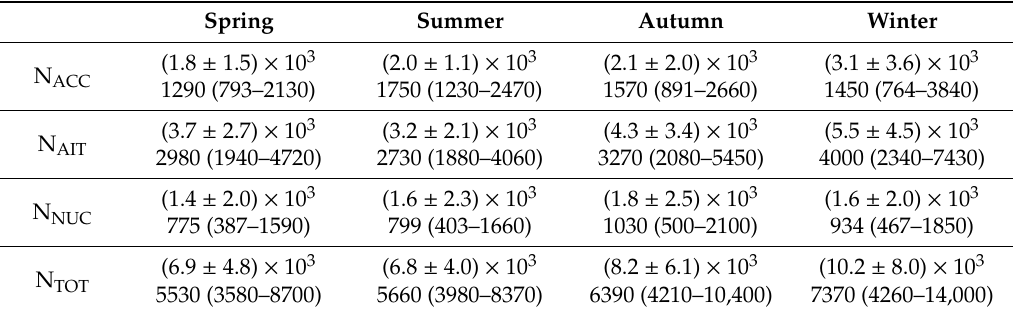
Table 2. Seasonal averages ± 1 standard deviation and median (25th–75th) percentiles of the accumulation, Aitken, nucleation, and total number concentrations (cm − 3